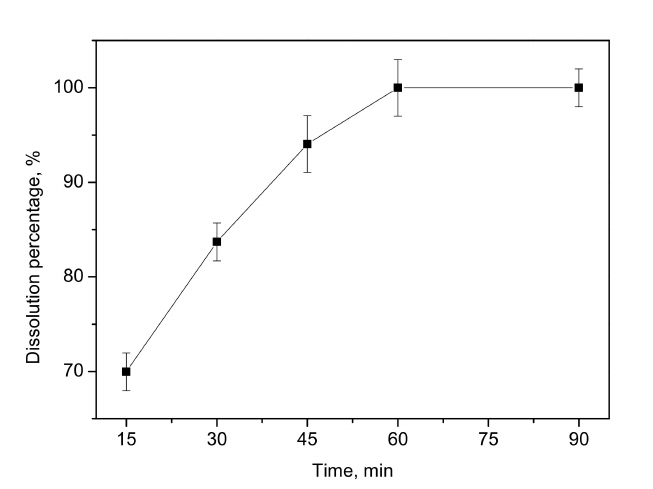
Figure 7. Effect of reaction time on the dissolution of Pd. Conditions: TBP = 3 M; diluent: kerosene; Pd/ TBP ratio = 1.25 g/L; Pd/HCl ratio = 12.5 g/L; Pd/H 2 O 2 ratio = 10 g/L; 60 ◦